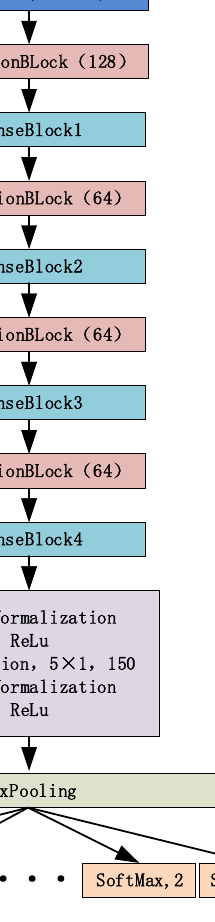
Figure 5. Mine MIMO depth receiver.